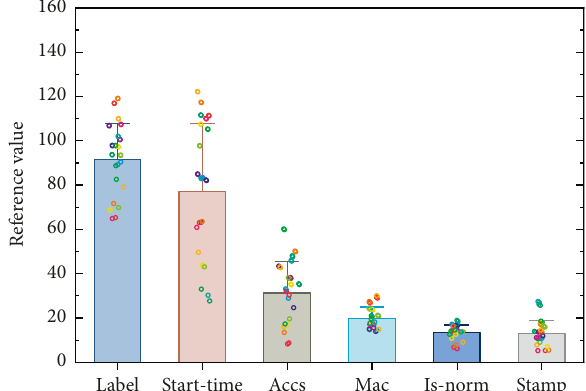
Figure 3: Columnar scatter diagram of reference standard value of source data